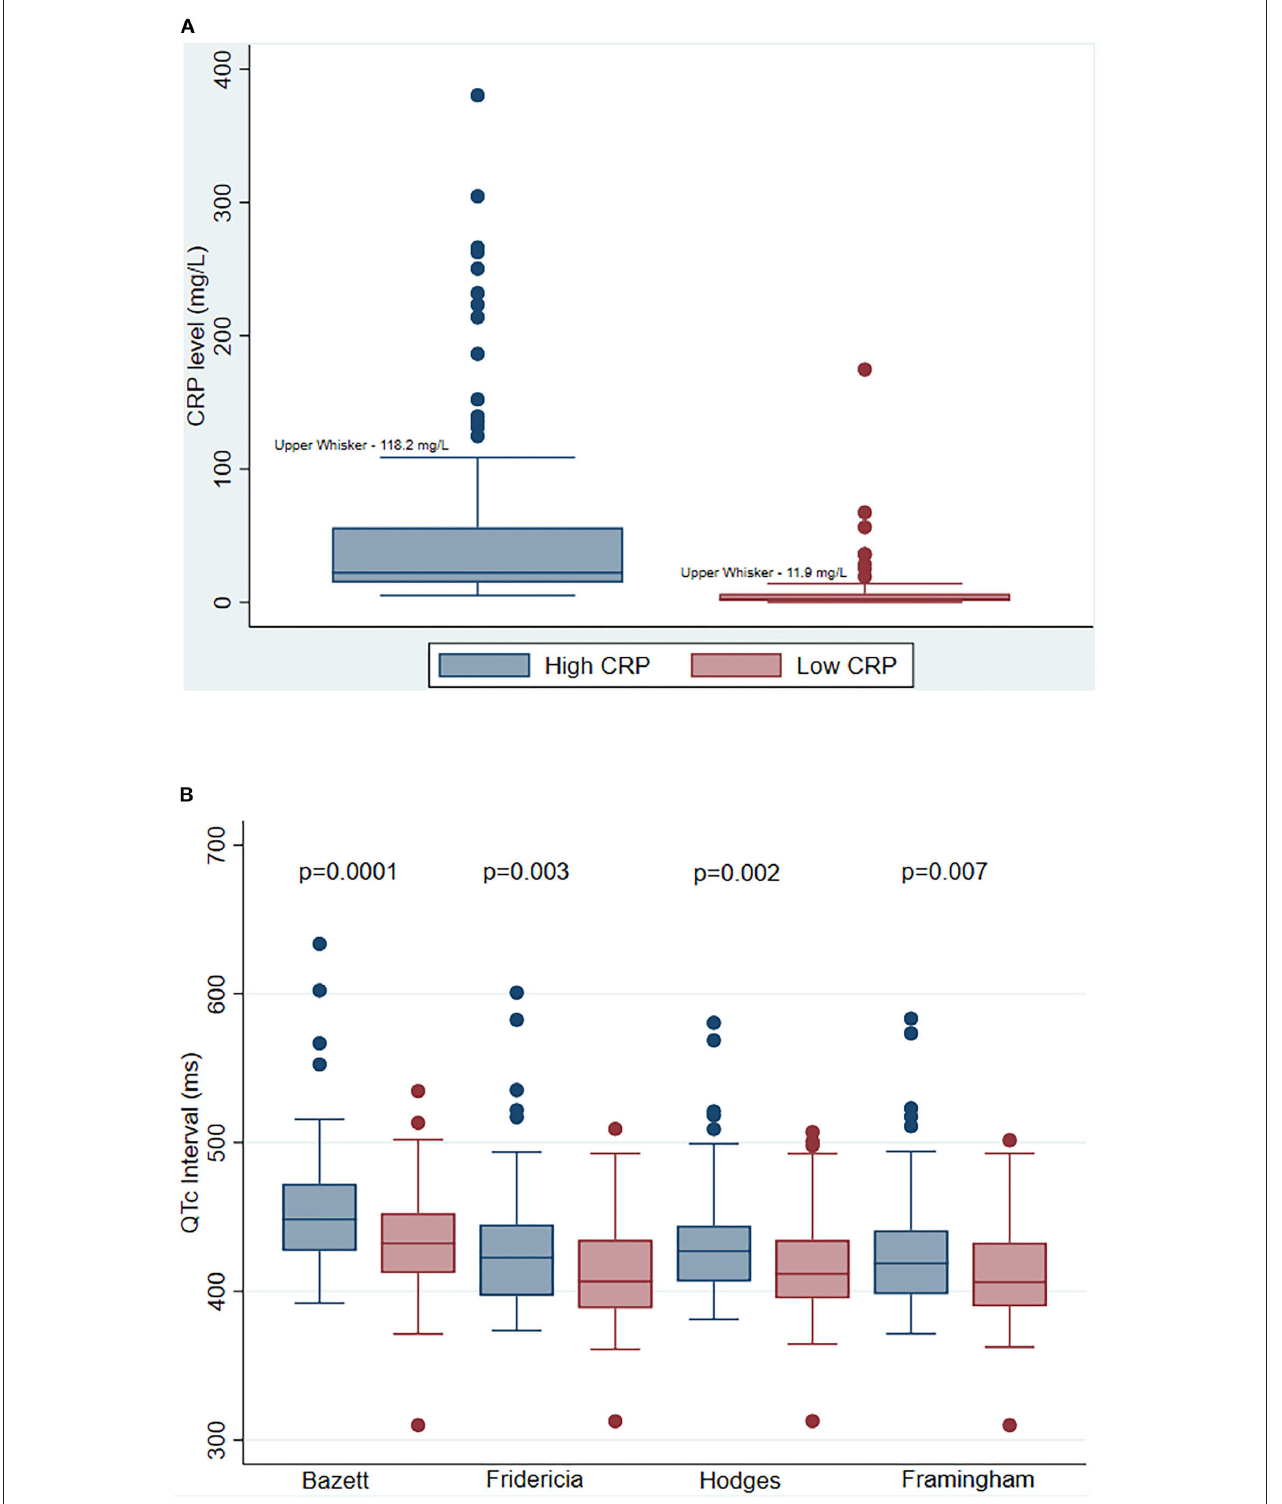
FIGURE 1 | Serial change in C-reactive protein (CRP) and corrected QT (QTc) interval. (A) Comparison of median CRP levels during high and low CRP values. Each bar represents the median CRP level ( + /– IQR) during high CRP values (blue), and during low CRP values (red). The P -Value indicates a statistical comparison between high CRP (blue) and low CRP (red) values. (B) Comparison of QTc interval measured by various correction methods at high and low CRP values. Each bar